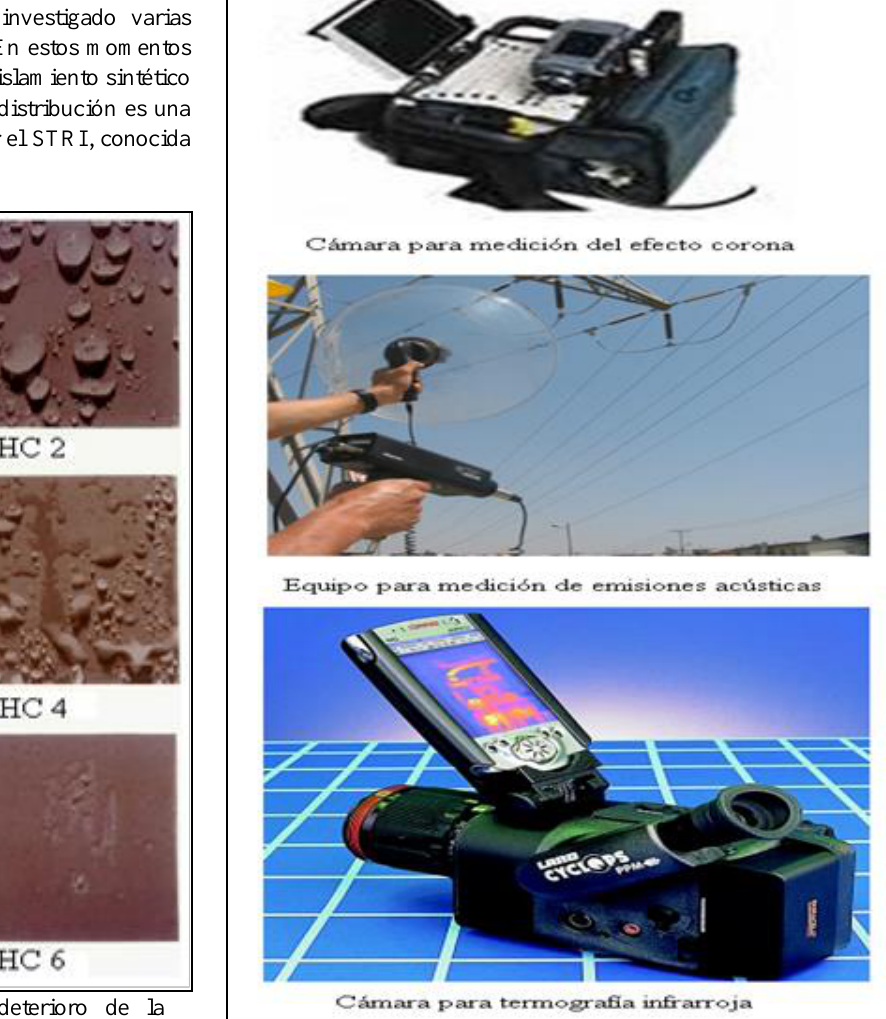
Figura 3. Nuevas tecnologías para el mantenimiento. Fuente: Autor,